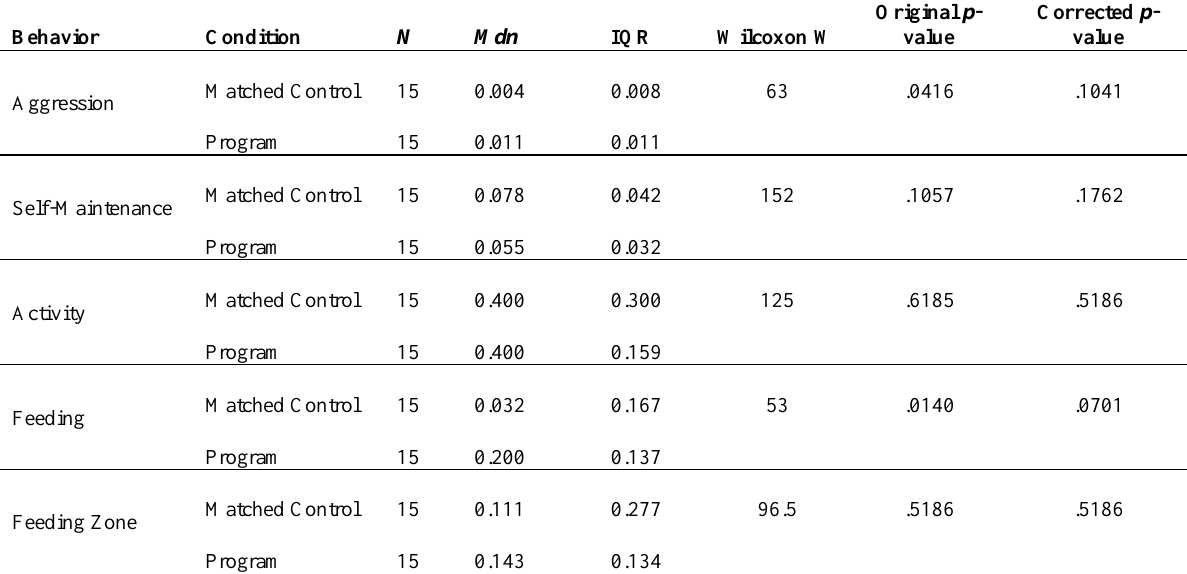
Results of Comparisons of Behavior During Programs and Matched Control Periods